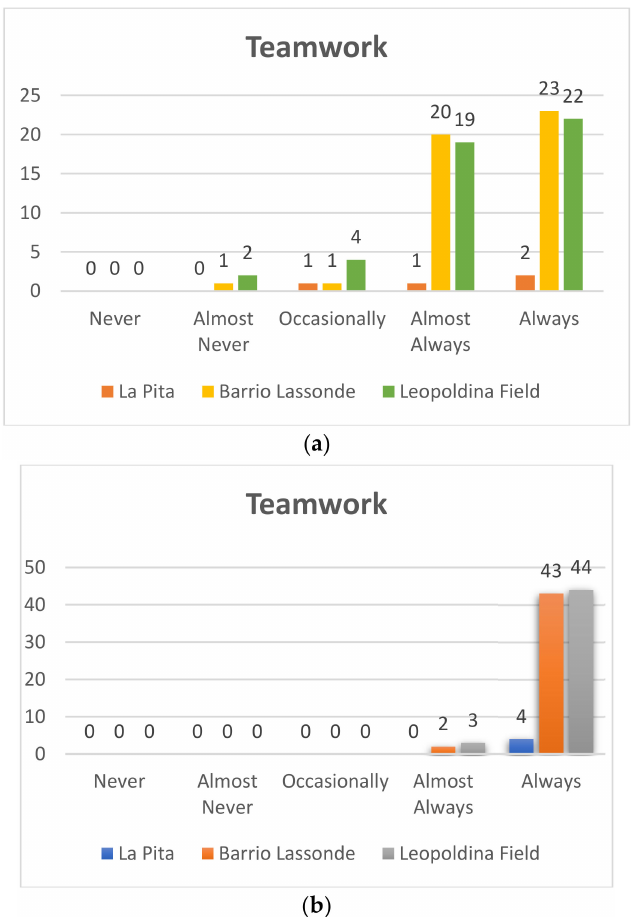
Figure 15. Kindergarden teamwork: Pre-Test ( a ) and Post-Test ( b